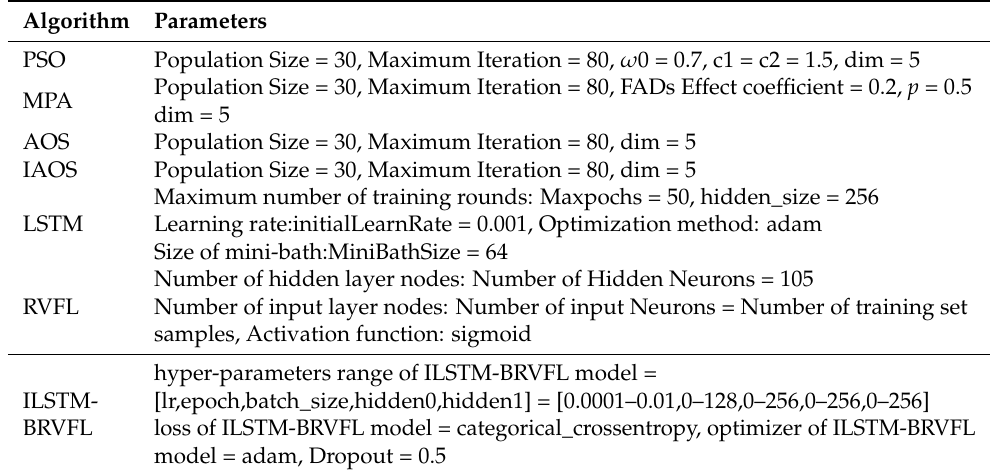
Table 3. Set the final parameters of the algorithm. Algorithm